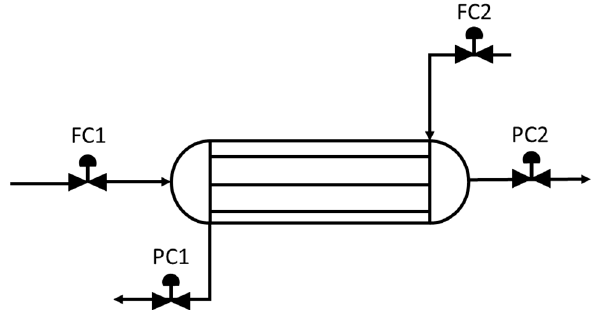
Figure 4. Depiction of the membrane reactor and control valves present in the simulation.